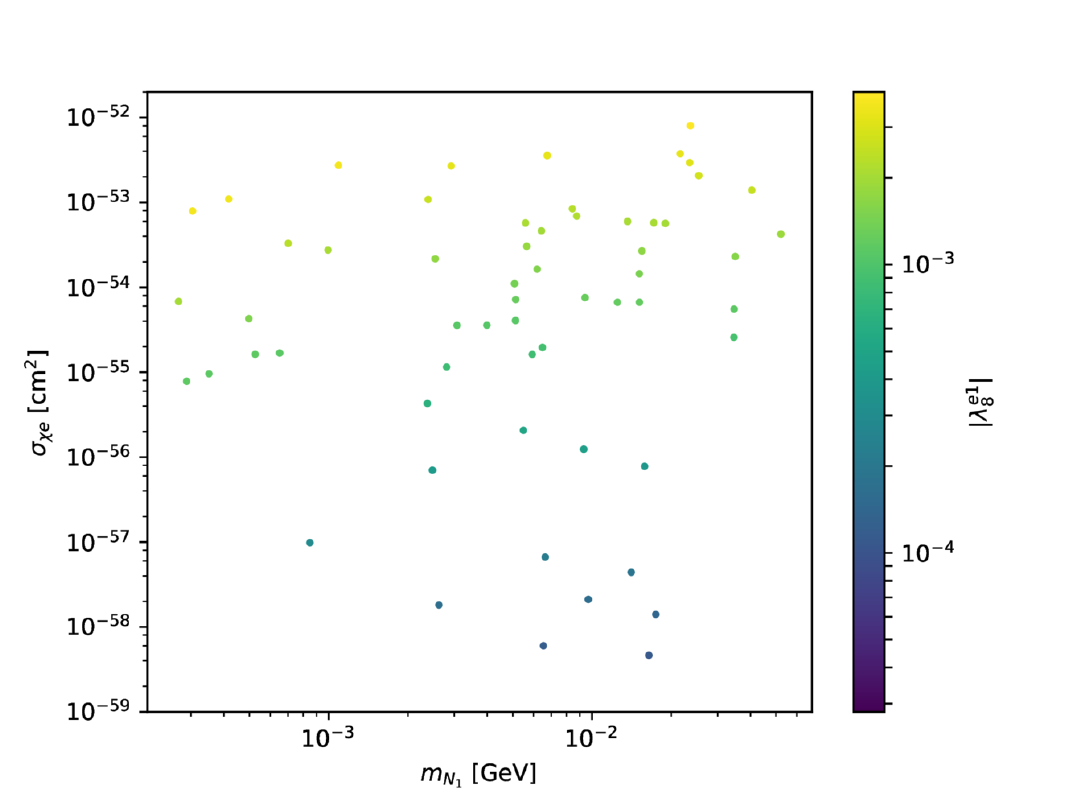
Figure 8 . Scattering cross section of right-handed neutrino DM o(cid:11) electrons versus the DM mass. The DM-electron coupling (cid:21) e 1 is shown on a colour 8